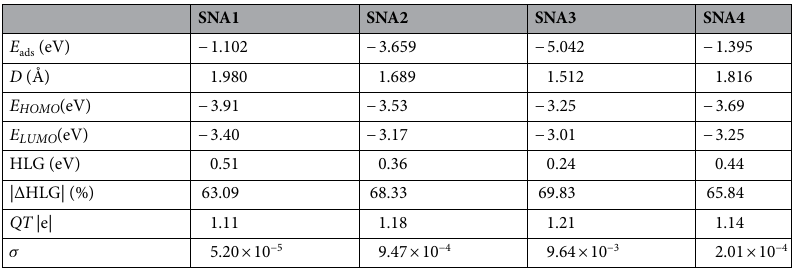
Table 3. The adsorption energy ( E ads ), adsorption distance ( D ), LUMO energy ( E LUMO ) , HOMO energy ( E HOMO ) , HOMO–LUMO gap (HLG), change of HLG (|ΔHLG|), charge transfer ( QT ) and conductivity (σ) for the adsorption of N- acetylcysteine molecule onto NiO–SWCNTs surface.